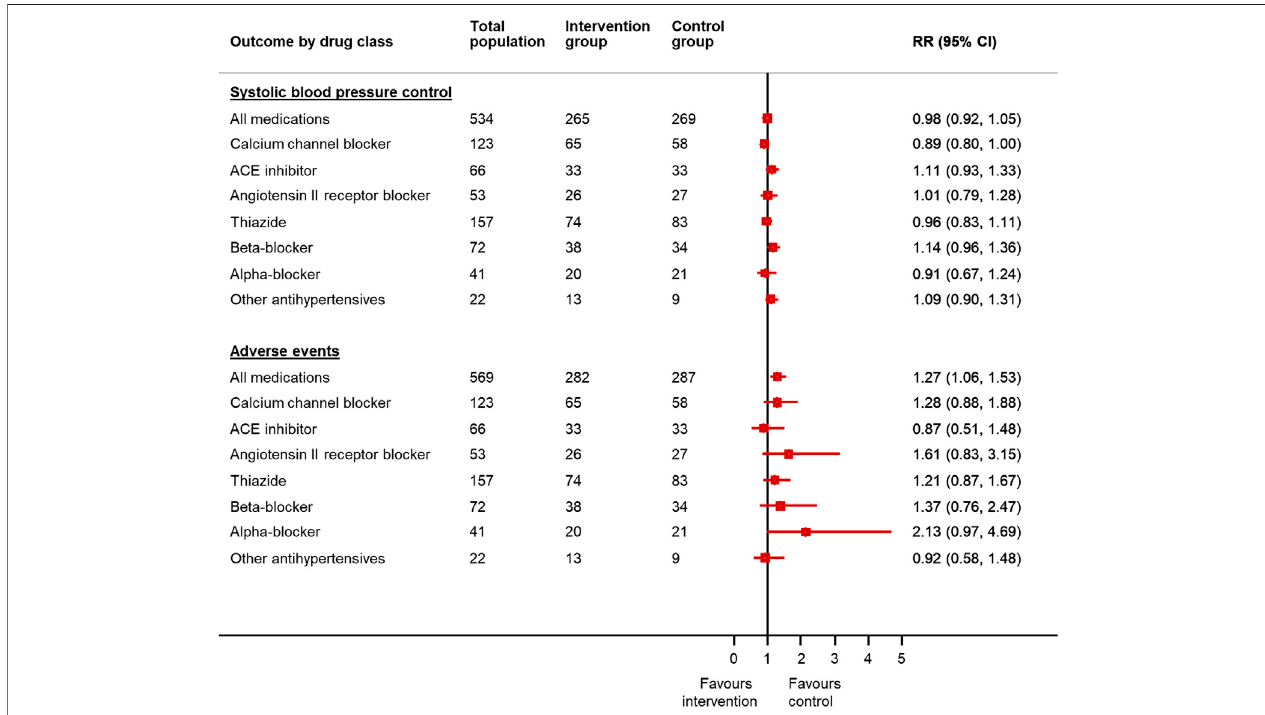
FIGURE 2 | Relative risk of blood pressure control and adverse events in patients reducing antihypertensive medication compared to usual care, by drug class chosen for withdrawal*. *Since the treating physician ’ s choice of medication to withdraw was made prior to consent and randomization, data were available for all randomizedparticipants, eventhoughonlyhalfwentontohavethemedicationwithdrawninthetrial.RR (cid:2) relativerisk;CI (cid:2) con fi denceinterval.Generalizedlinearmixed model with binomial error and log link, with factors predictive of physician choice of drug to withdraw (see Table 2 ) and baseline systolic blood pressure, gender, cognitive function (MoCA Score), EQ-5D-5L Index and Searle Frailty Index as fi xed effects.